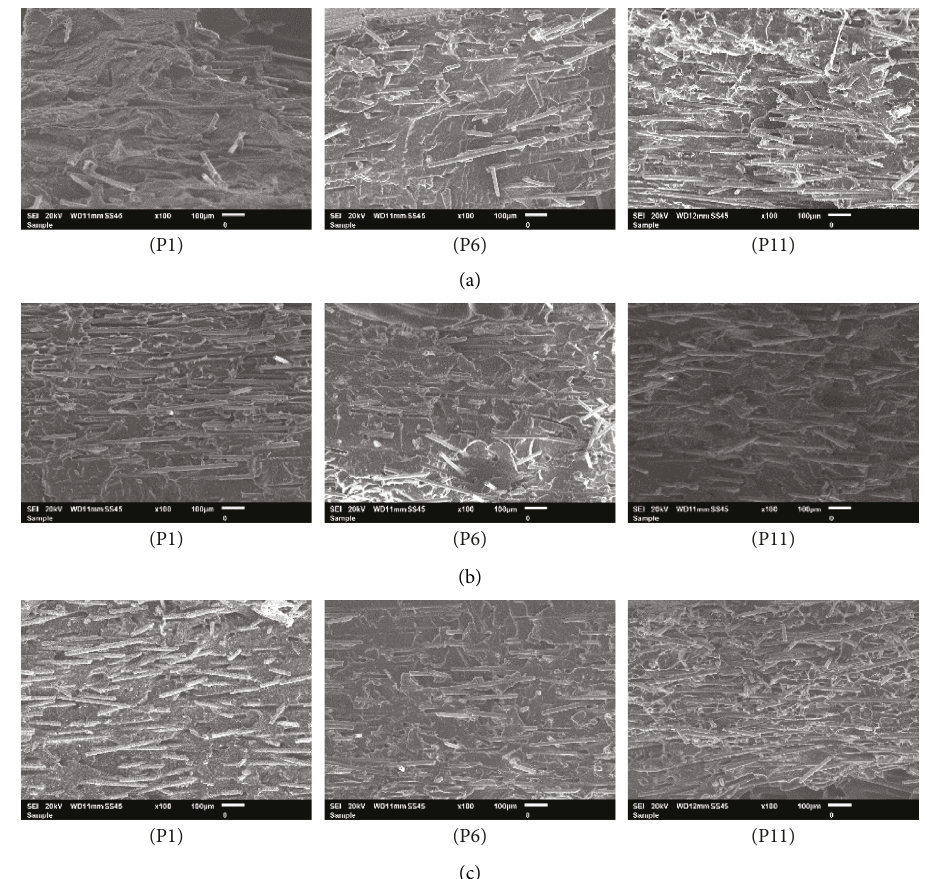
Figure 7: Fiber orientation distribution of different fiber mass content along the flow direction, (a) SEM images of 20% GFRPP, (b) SEM images of 30% GFRPP, and (c) SEM images of 40% GFRPP.